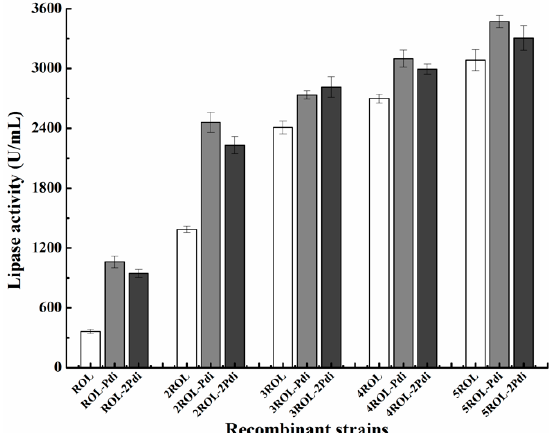
Figure 1. Rhizopus oryzae lipase (ROL) activity of the recombinant strains harboring different copy numbers of ROL gene and protein disulfide isomerase ( Pdi ) gene. All values are presented as the mean ± standard deviation of three independent experiments.